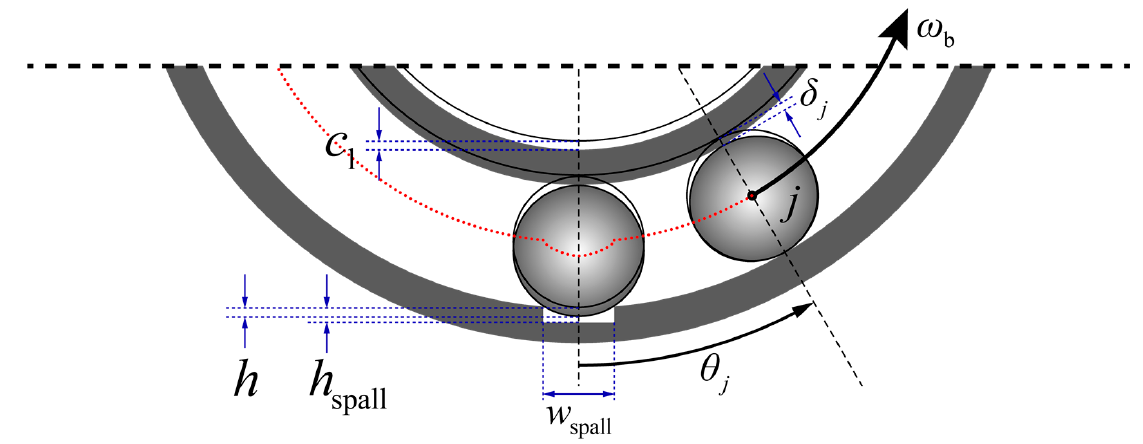
Figure 10. Bearing outer raceway spalling fault.